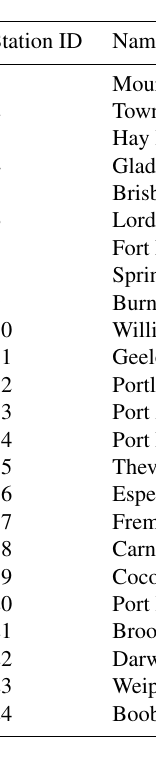
Table 1. Start and end dates of the analysed tide gauge records, including names and running index for identification in Fig.